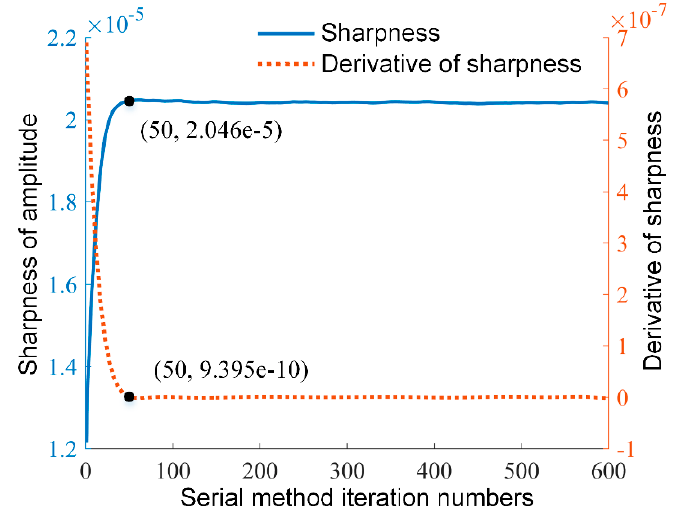
Figure 11. The convergence curve and the corresponding derivative curve of the serial method.